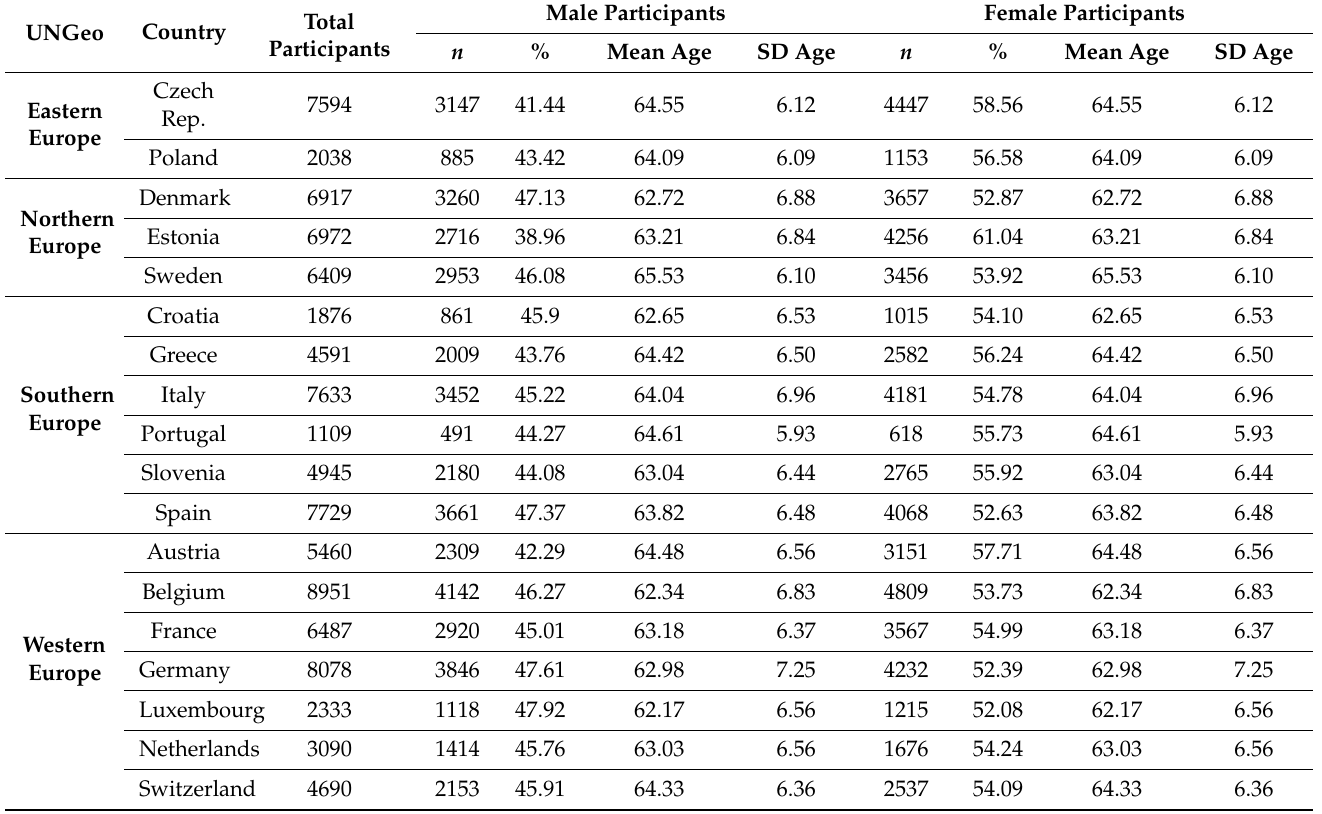
Table 1. Participants’ characteristics by country and sex.